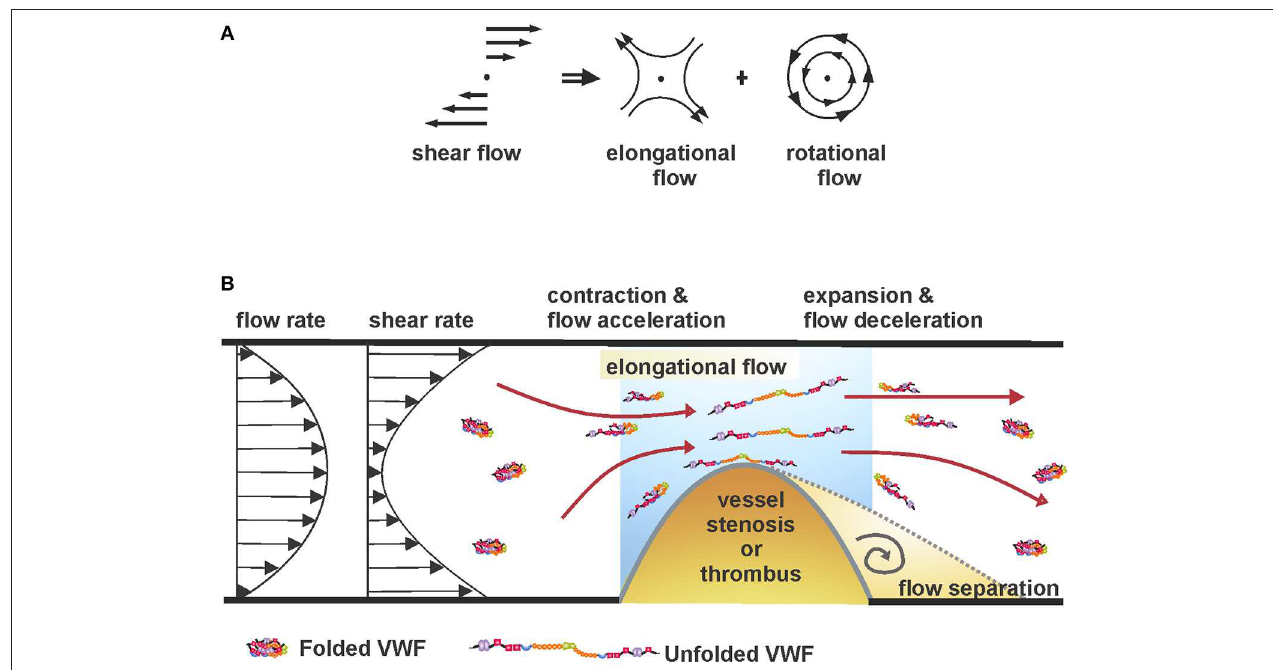
FIGURE 1 | (A) Shear flow, as a superimposition of rotational and elongational flow components (71, 72). (B) Unfolding of coiled VWF under elongational flow or shear rate gradients at sites of vessel stenosis.